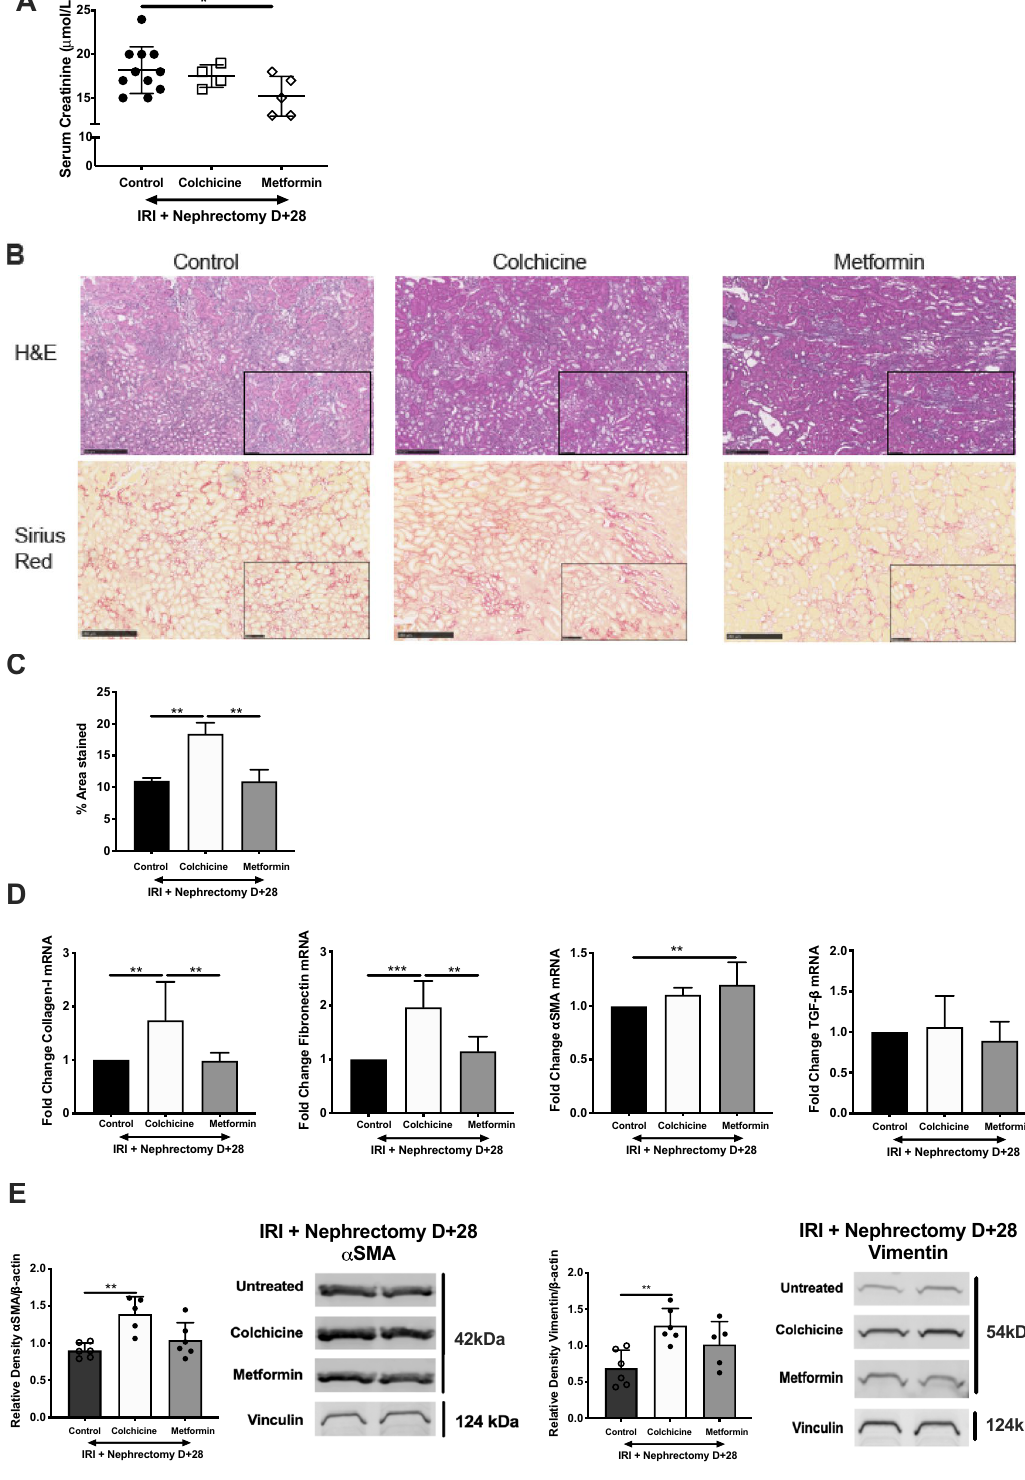
Figure 6. Colchicine worsens development of and metformin fails to modify renal interstitial fibrosis. Age-matched male C57BL/6 mice were subjected to unilateral renal ischemia reperfusion injury + contralateral nephrectomy. Colchicine and metformin were regularly administered from D + 7. At D + 28 post-IRI + Nephrectomy ( A ) serum creatinine was measured. ( B ) Kidney tissues were sectioned and stained with hematoxylin and eosin (H&E) or Sirius red, followed by ( C ) quantitative analysis of fibrosis from n = 6 mice. Whole kidney homogenate was prepared for qPCR analysis. Samples were collected for RNA isolation, cDNA synthesis and RT-PCR performed for ( D ) type I collagen, fibronectin, αSMA and TGF-β. Protein was resolved by SDS-PAGE. ( E ) Quantification of protein expression, in addition to representative western blots for αSMA and vimentin are shown. Densitometry is presented as the mean ratio of target protein to loading control (β-actin or vinculin) ± SD from n = 5–7 samples. PCR was run in triplicate and results are presented as fold change ± SD from n = 6 independent experiments, * p < 0.05, ** p < 0.01, *** p < 0.001, **** p <